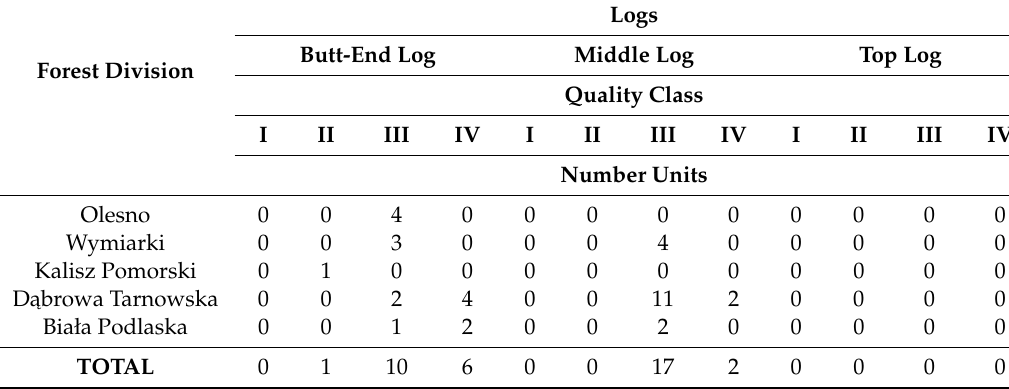
Table 11. Amount of sawn timber by defect: shakes (PN-75 / D-96000).